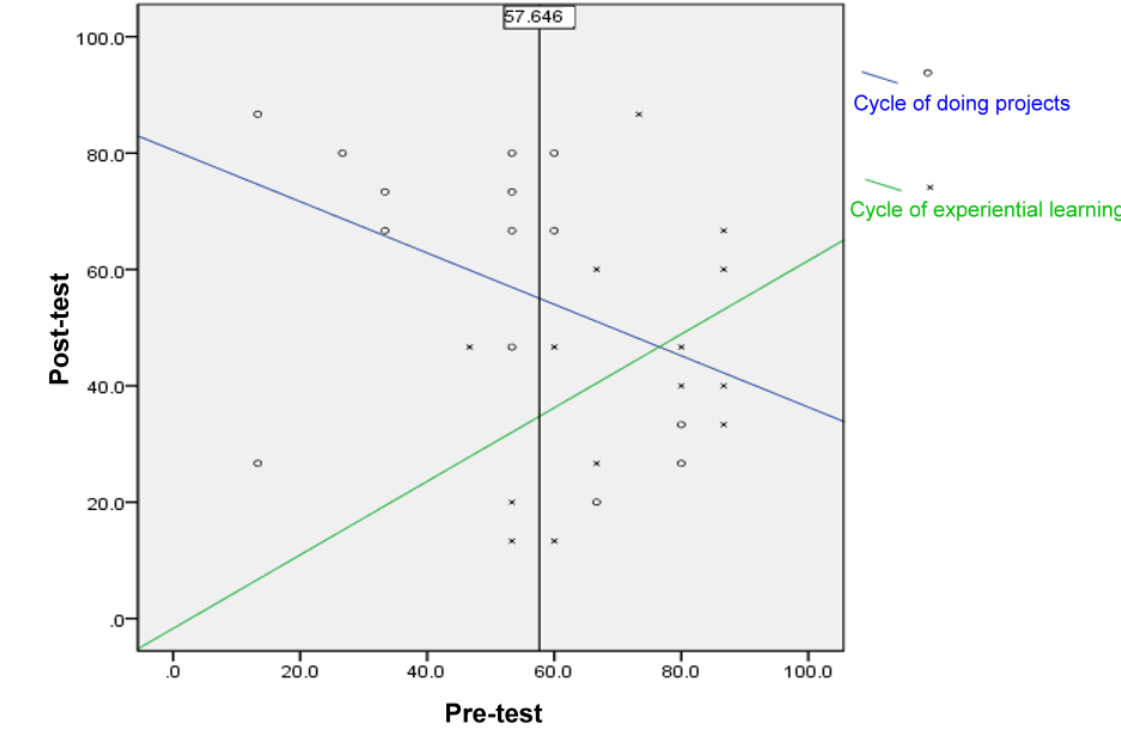
Figure 7 Results of Johnson-Neyman Process for Males Using Different Learning